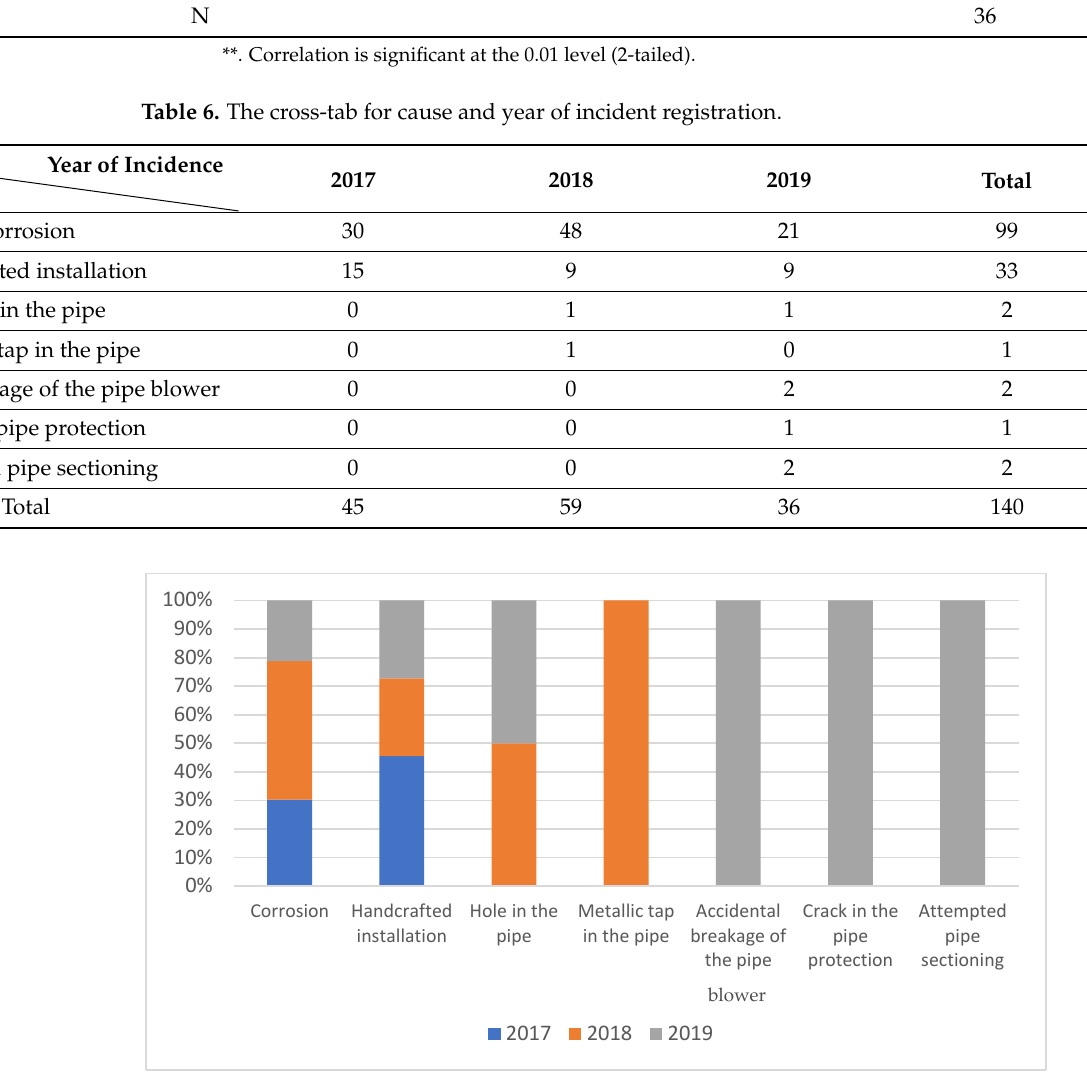
Figure 4. The annual structure of causes of incidents.